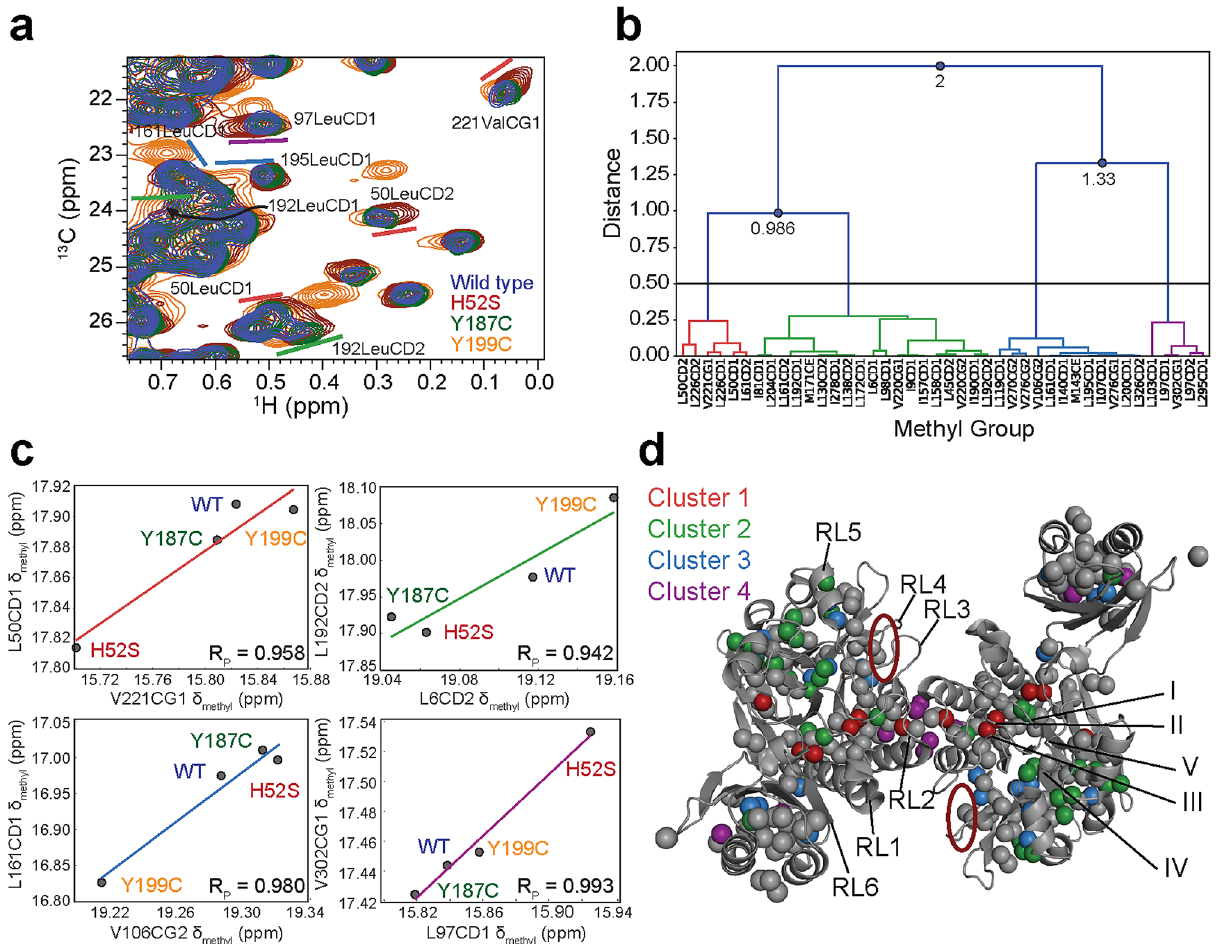
TROSY NMR spectra for wild type (blue), H52S (red), Y187C (green), and Y199C (orange) Pf Mre11 ND . Peak assignments are given for several peaks that were considered for CHESCA. The colored bars correspond to the cluster where that peak is located (see ( b ) and ( d )). ( b ) Dendrogram of methyl groups determined by CHESCA. A distance cut-off of 0.5 (horizontal black line) was used to define the clusters. Clusters 1, 2, 3, and 4 are colored red, green, blue, and purple, respectively. ( c ) Representative pairwise inter-residue correlation plots of the combined chemical shifts (δ methyl ) for each of the four clusters. The Pearson’s correlation coefficient (R P ) is given in the lower right corner. ( d ) Structure of Pf Mre11 ND highlighting the side-chain methyl groups whose CSPs from mutation cluster according to CHESCA. Methyl groups not clustered are colored grey. DNA recognition loops (RL) and conserved catalytic motifs (I–V) are indicated. The location of the conserved basic patch is outlined by the red